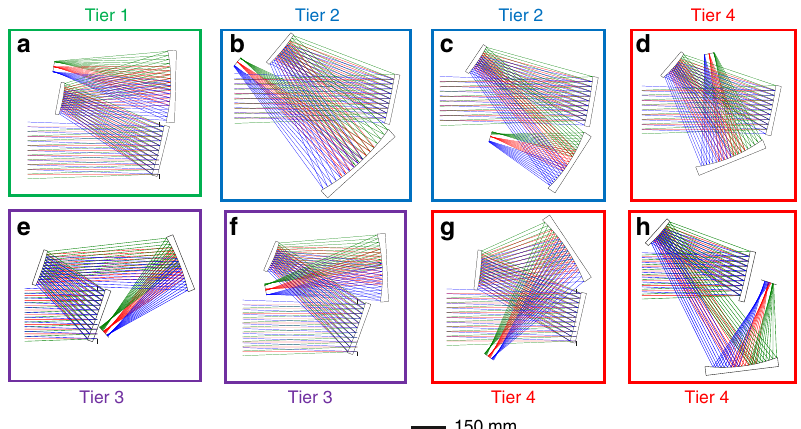
Fig. 1 A comprehensive selection of possible geometries for unobscured positive-negative-positive (PNP) re fl ective imagers. Eight different geometries, differentiated by the folding directions of the mirrors, were found to be feasible for a three-mirror PNP re fl ective imager. Here, each system has planar symmetry about a plane parallel to the page. The different colors of the rays indicate separate points in the fi eld-of-view (FOV). a The Tier 1 design has the greatest potential to be corrected using freeform surfaces; b , c the Tier 2 designs have some potential, but are limited by volume; e , f the Tier 3 designs have limited correction potential; d , g , h the Tier 4 designs have the least potential to be corrected. These tiers were determined by applying the three